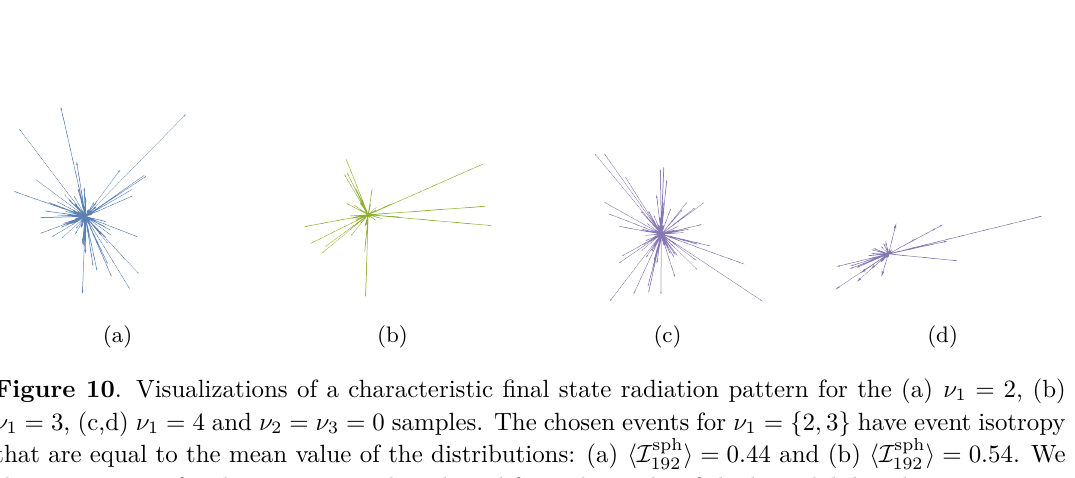
Figure 9 . Same as figure 5 but for the two field scenario with ν 2 = ν 3 = 0 , and ν 1 = 2 (blue), ν 1 = 3 (green), and ν 1 = 4 (red). Note that average multiplicity is lower and event isotropy is higher than the single field cases in figure 5. The appearance of plateaus in the branching ratios can greatly increase the amount of KK violation per event.